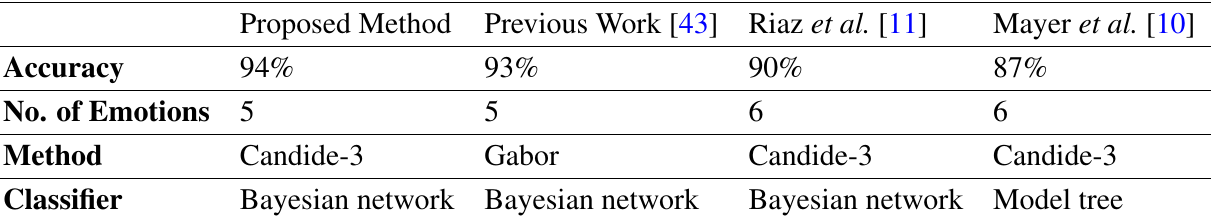
Table 8. Comparison between different emotion recognition